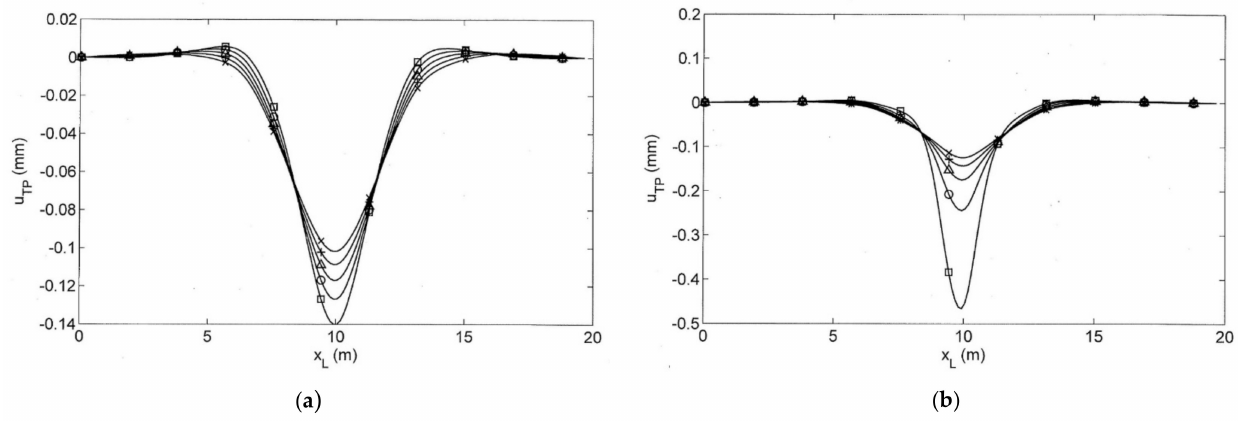
Figure 7. Calculated distributions of the track-plate displacements for different thicknesses of the plate t P = 0.1, 0.15, 0.2, 0.25, and 0.3 m: ( a ) intact slab track and ( b ) track plate damage (gap to base layer) of length L D = 1.95 m (FEM